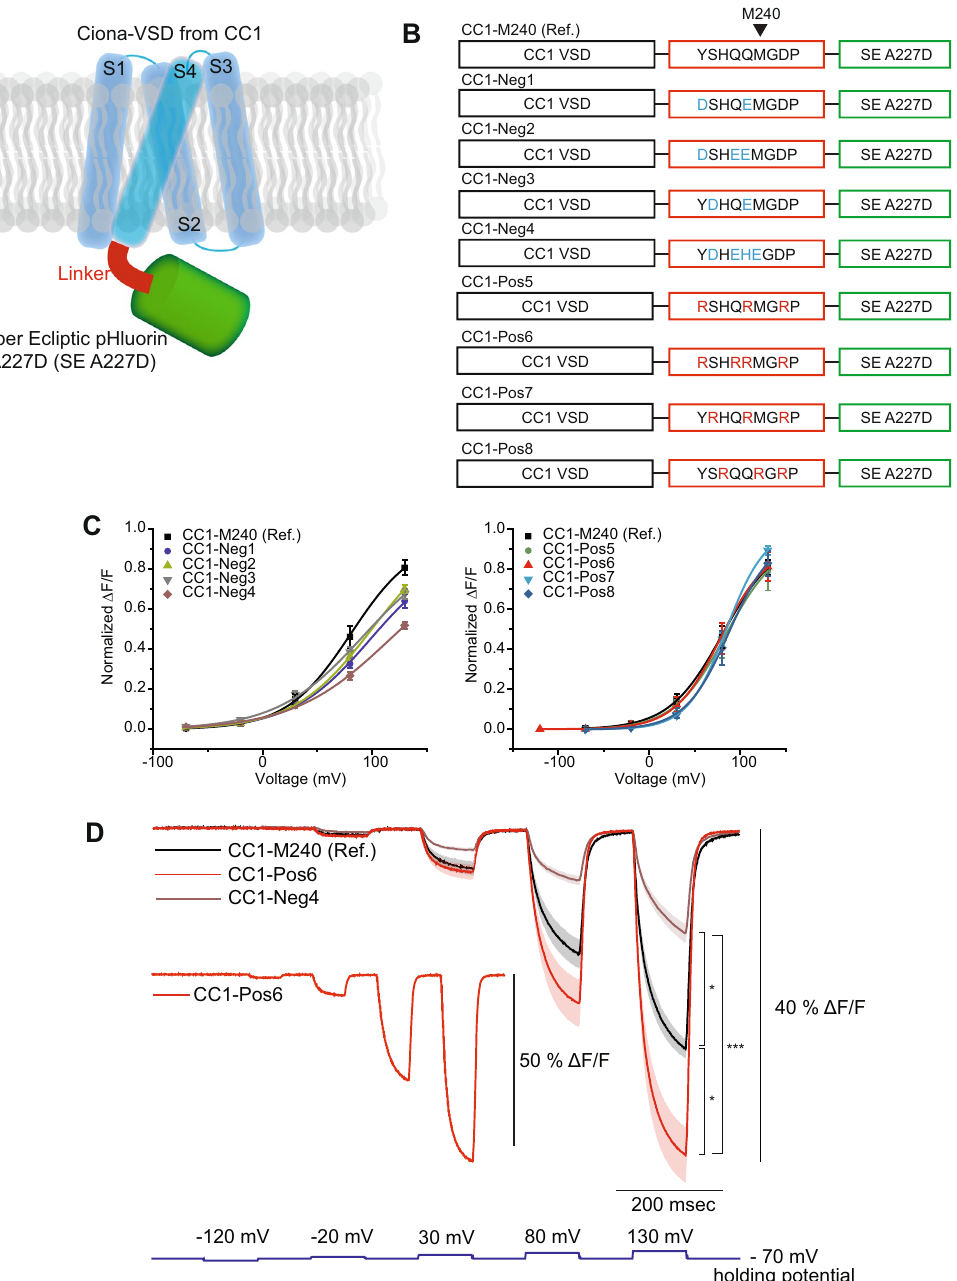
Figure 1. Altering the charge composition of the linker domain affected the size of the voltage-dependent optical signal. ( A ) Schematic of the GEVI. The voltage-sensing domain is in blue. The linker segment is in red, and the FP is in green. ( B ) Composition of the negatively and positively charged linker constructs. The VSD is from CC1, a Ciona intestinalis derived GEVI with V 1/2 near + 80 mV. Introduction of negatively charged amino acids in the linker are shown in blue and positively charged ones in the linker are shown in red. ( C ) The Boltzmann fit of normalized optical signal (zero – minimum, one, maximum) in response to voltage. Comparison between CC1-M240 and the negative linker variants (left) and the positive variants (right). ( D ) The averages of CC1-M240, CC1-Pos6 and CC1-Neg4 optical traces responding to stepped voltage pulses. Inset shows a fluorescence trace from an HEK 293 cell expressing CC1-Pos6 with more than 50% signal size during a 200 mV voltage pulse. ‘Ref.’ indicates ‘Reference’. The shaded area denotes standard error of the mean. The number of cells averaged for each construct; CC1-M240: 4, CC1-Neg1: 3, CC1-Neg2: 4, CC1-Neg3: 5, CC1- Neg4: 4, CC1-Pos5: 4, CC1-Pos6: 6, CC1-Pos7: 6, CC1-Pos8: 4. Asterisks in D indicate statistically significant differences between means compared ( * p < 0.05 and *** p <